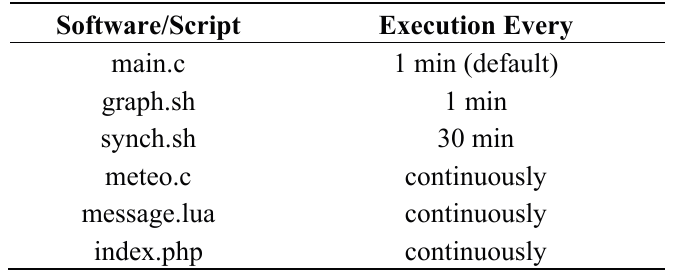
Table 12. Data-acquisition system